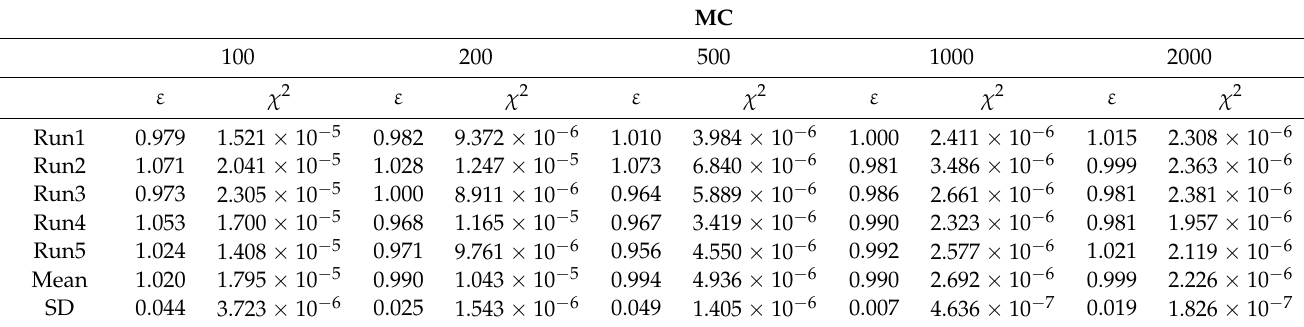
Table A2. Dependence of the quality of the DE fitting on MC (only one free parameter). Results of the PSIIRC linear spectroscopy fitting obtained after 5 runs of DE are shown for five different MC values. FWHM Ω = 180 cm − 1 . The target function is the artificially created experimental data with MC = 10,000.